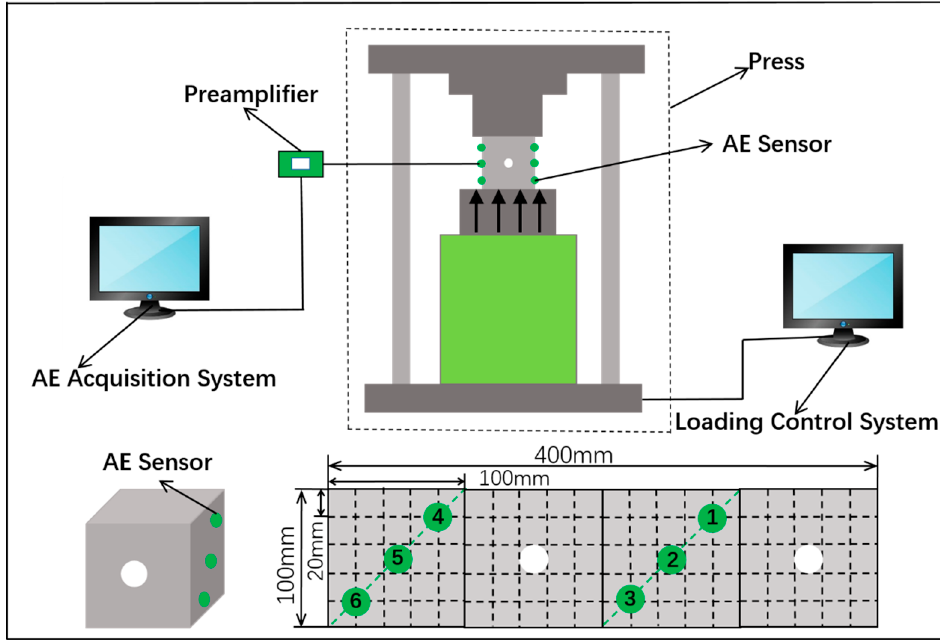
Figure 2. Schematic diagram of the experimental system.